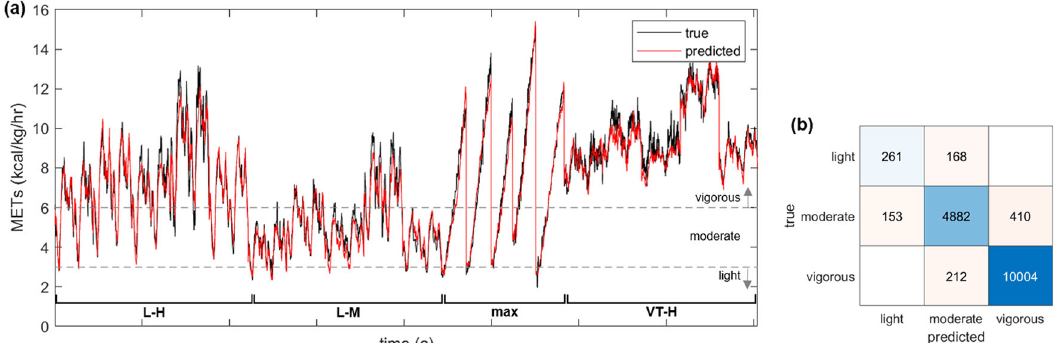
Fig. 5 Temporal prediction of physical activity in the test set. a Prediction of metabolic equivalent of task (METs) over all test data (four protocols per participant across the fi ve-participant test set) concatenated into one plot and visually grouped by protocol for quantifying physical activity levels according to global guidelines. b Confusion matrix of physical activity classi fi cation (light: <3.0; moderate: 3.0 – 5.9; vigorous: ≥ 6.0).